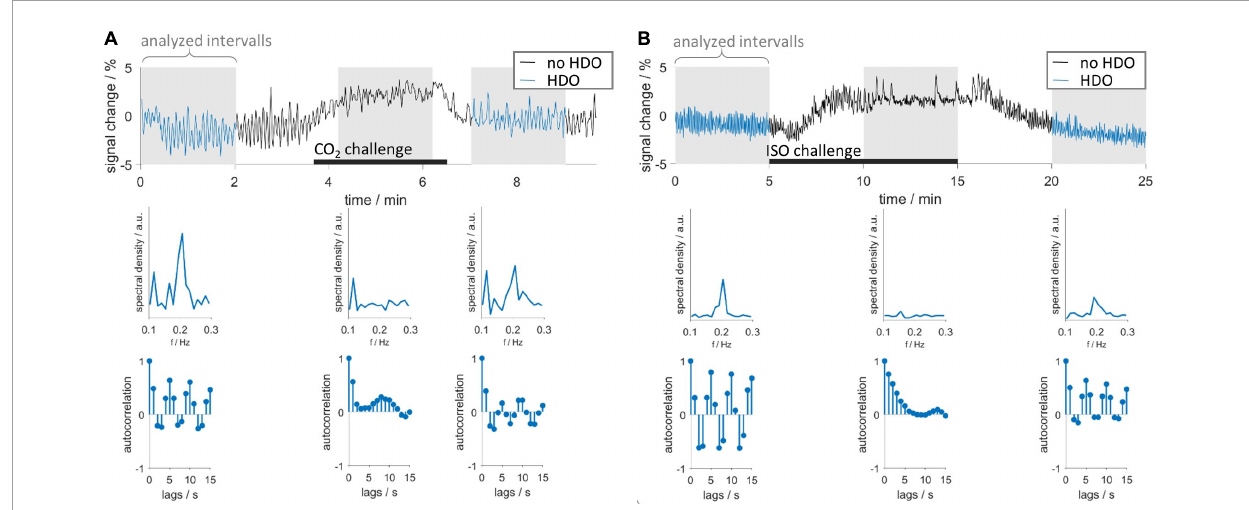
FIGURE4 Vasodilation interrupts HDO. Vasodilation was induced by administration of (A) CO 2 and (B) ISO. First row: exemplary time courses recorded during CO 2 and ISO challenge. Three segments were analyzed using the HDO detection algorithm (gray background): before, during and after the respective challenge (black bars). Time course segments classified as oscillating were colored blue. Second and third row show spectra and autocorrelation functions, respectively, of the corresponding sections